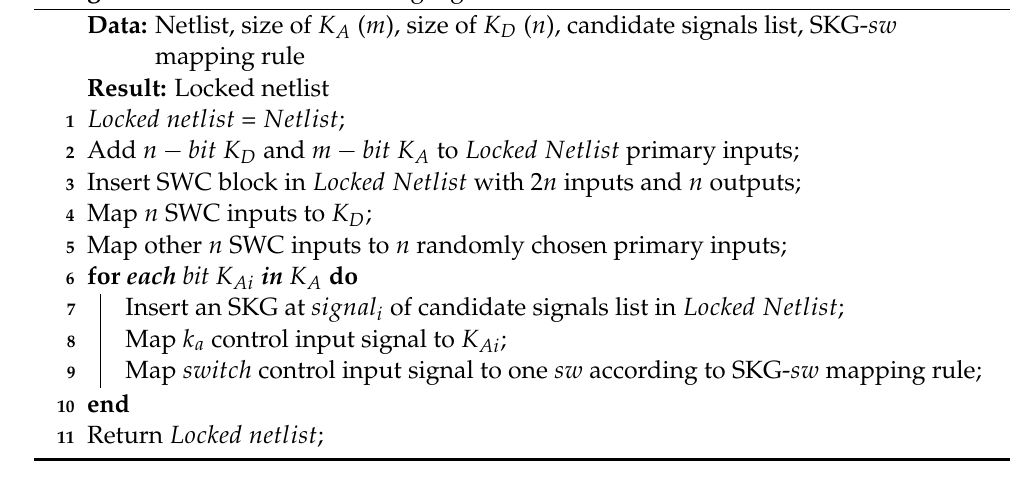
Algorithm 2: SKG-Lock+ locking algorithm.